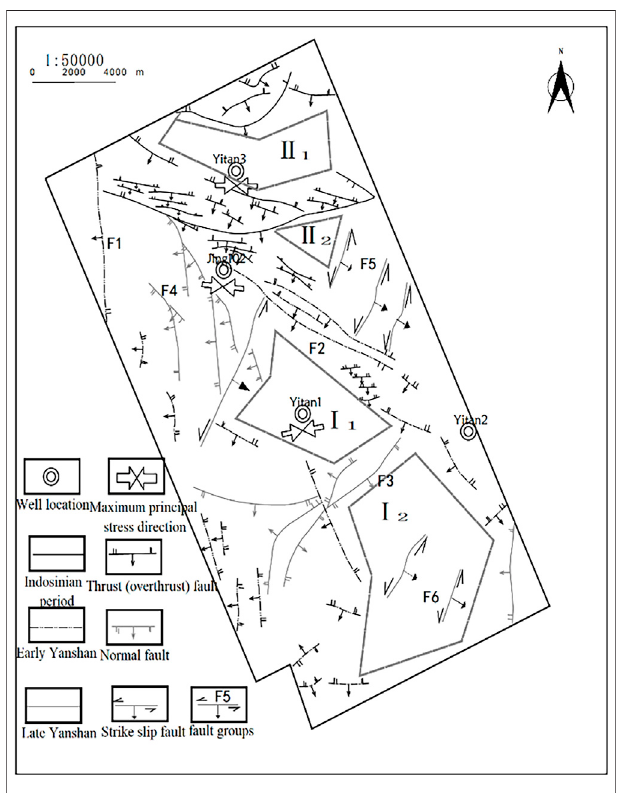
FIGURE 3 | The characteristics of the fracture structure and the map of the favorable area selection.